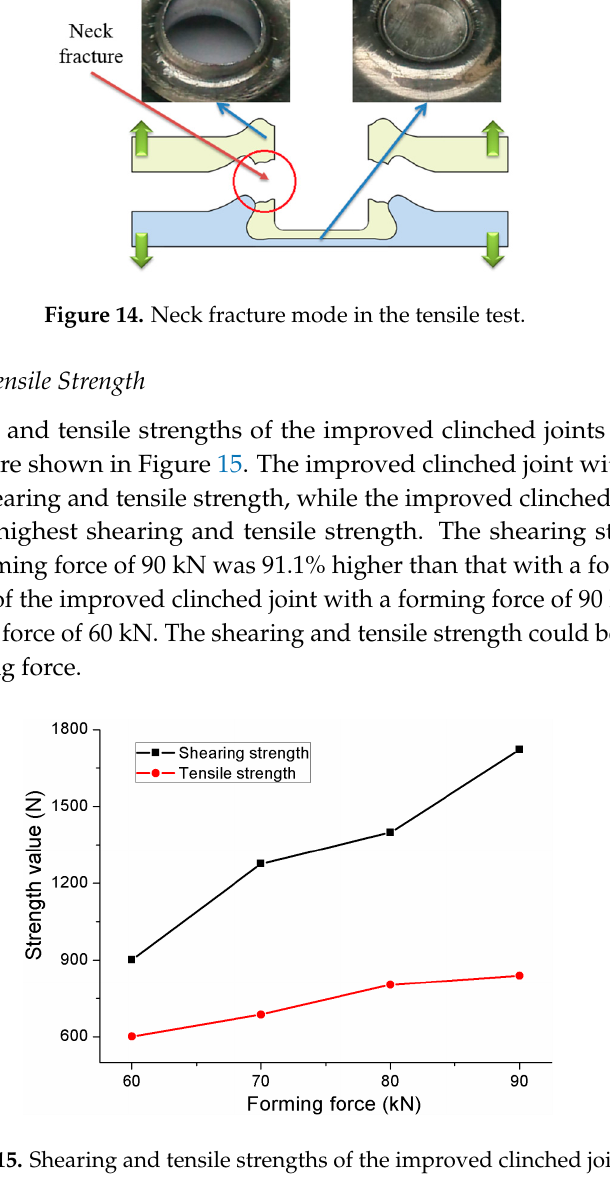
Figure 16. Shearing and tensile force-displacement curves of the improved clinched joints. 5. Conclusions In the present study, an improved clinched joint was investigated by experimental methods. The improved clinching tools with a flat anvil were used to produce the improved clinched joints